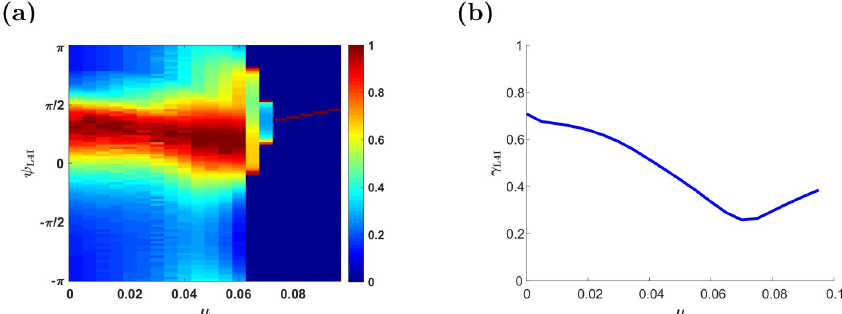
Fig 9. The effect of the non-linearity parameter, μ . (a) The distribution of preferred phases of L4I neurons, κ L4I , is shown by color as a function of μ . (b) The modulation depth, γ L4I , is depicted as a function of μ . The parameters used here were: κ VPM = 1, ψ VPM = 5 π /6, γ = 0.9, D = 10hz, and d = 3ms. The temporally asymmetric STDP rule, Eq (9), was used with: τ − = 50ms, τ + = 22ms, α = 1.1 and λ = 0.01.